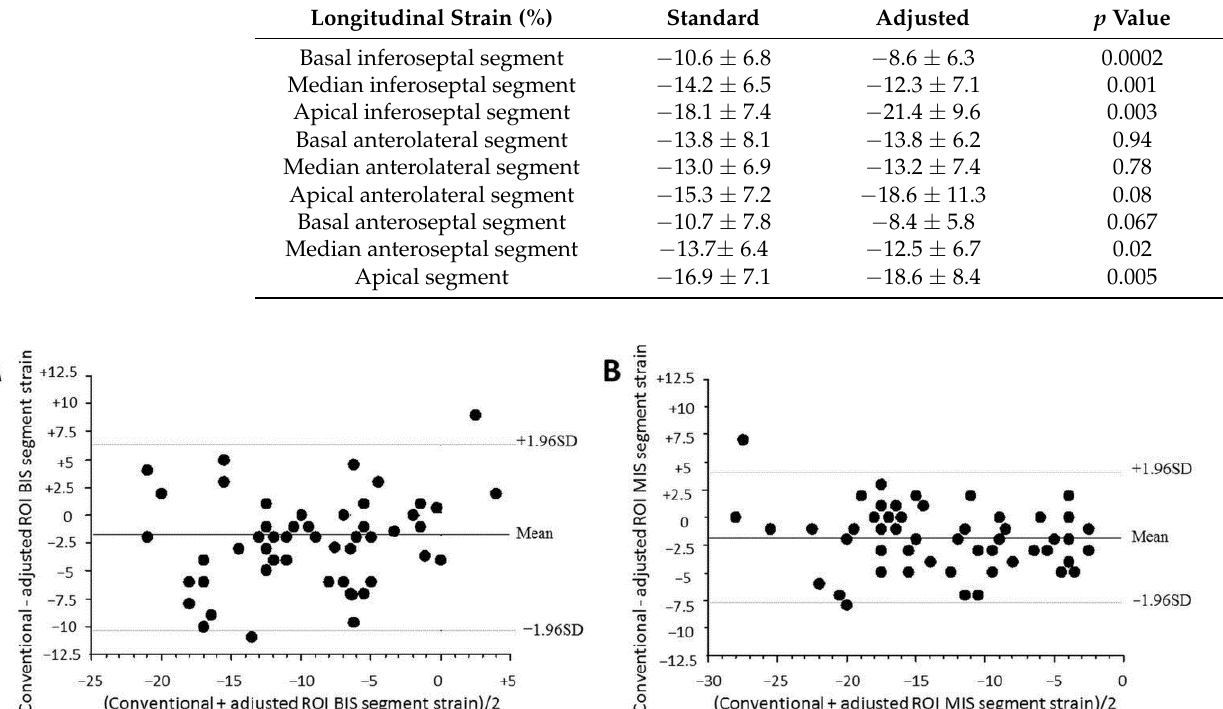
Table 3. Regional longitudinal strain with standard analysis and strain adjusted for thickness (mid-wall layer).